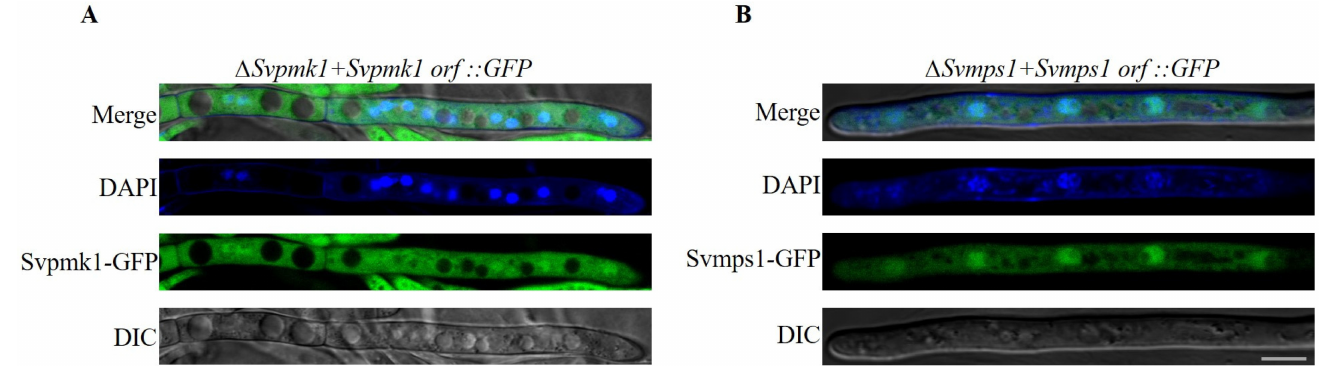
Figure 8. Subcellular localizations of SvPmk1-GFP and SvMps1-GFP. ( A ) SvPmk1-GFP is expressed throughout the cytoplasm and the nucleus. ( B ) SvMps1-GFP is co-localized with DAPI signal in the nuclei of the fungal mycelia. The mycelia were cultured in PDB at 25 ◦ C, 180 rpm for 18 h. Scale bar = 20 µ